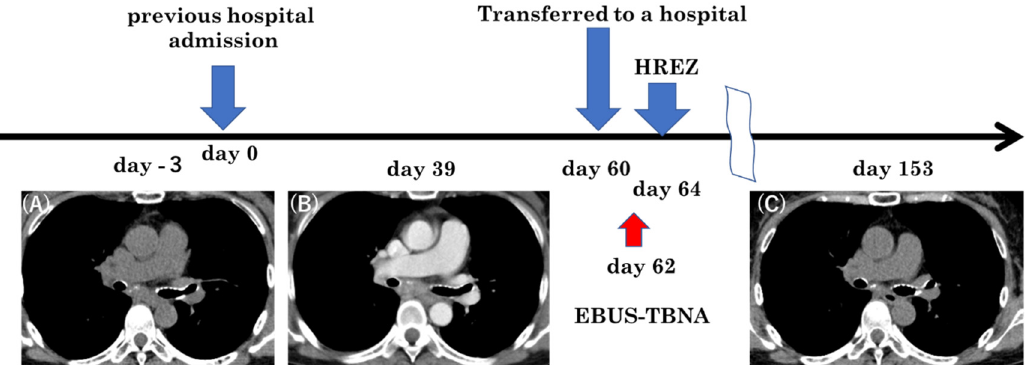
Figure 2. Chest CT scan revealing enlargement of subcarinal lymph nodes, initially undetected. ( A ) An increase in the size of the lymph nodes when treated as a fever of unknown origin. ( B ) Shrinkage of lymph nodes after anti-tuberculous treatment. ( C ) HREZ: isoniazid, rifampicin, ethambutol, py-